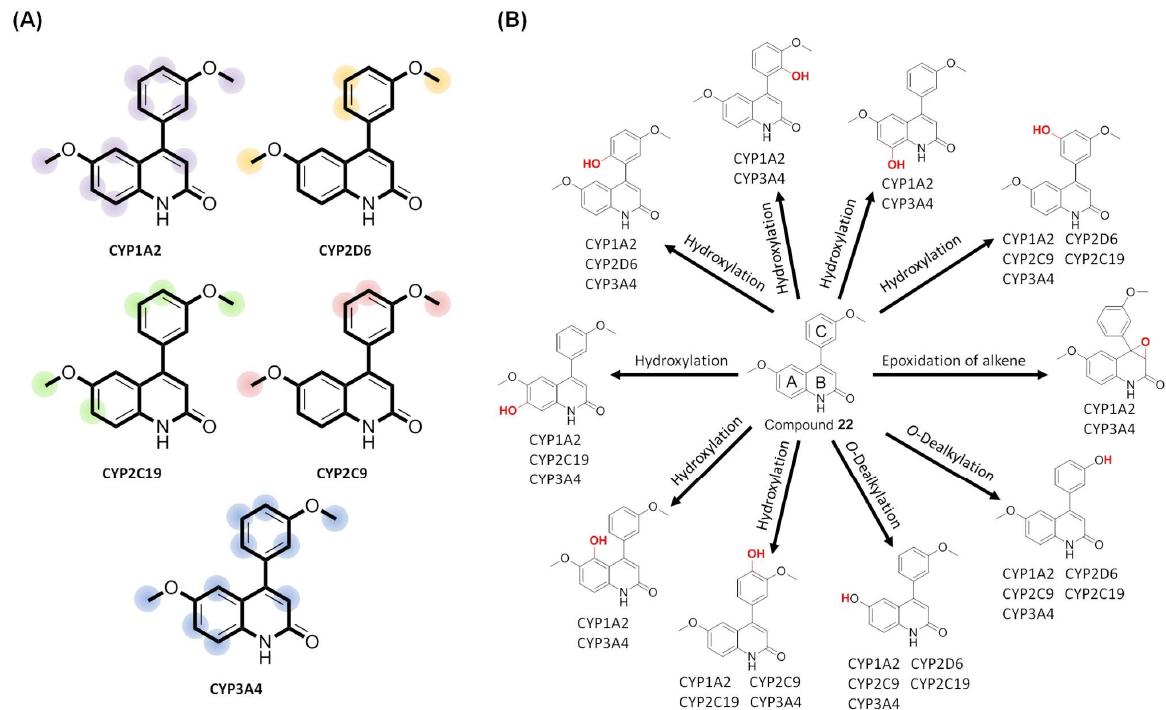
Figure 8. Applying a metabolism predictor to anticipate sites of metabolism (SOMs) and the metabolite structures of compound 22 . ( A ) SOM prediction (SOMP) predicted metabolic positions of compound 22 by CYP450 isoforms, including CYP1A2, CYP2D6, CYP2C19, CYP2C9, and CYP3A4. ( B ) The biotransformation of compound 22 was predicted by phase I (CYP450) transformation.